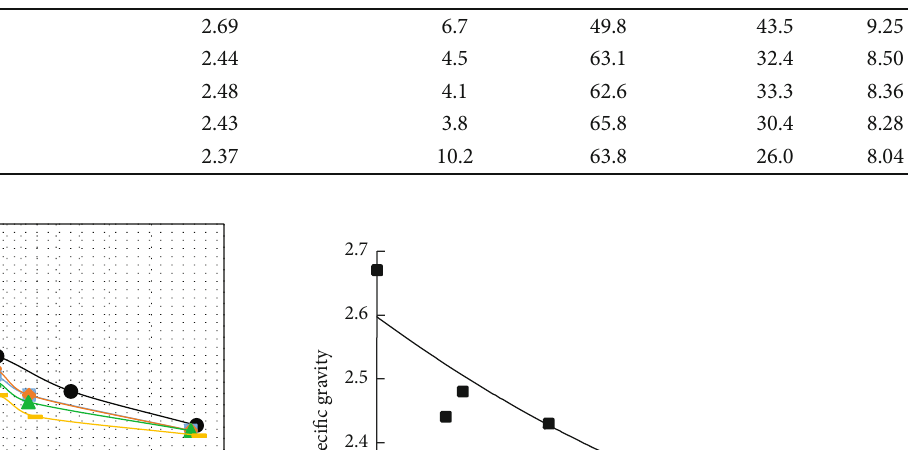
Table 2: Physical and chemical properties of the soil before and after modi fi cation with aluminum compounds. Hydroxyl aluminum content/(mmol · g -1 )